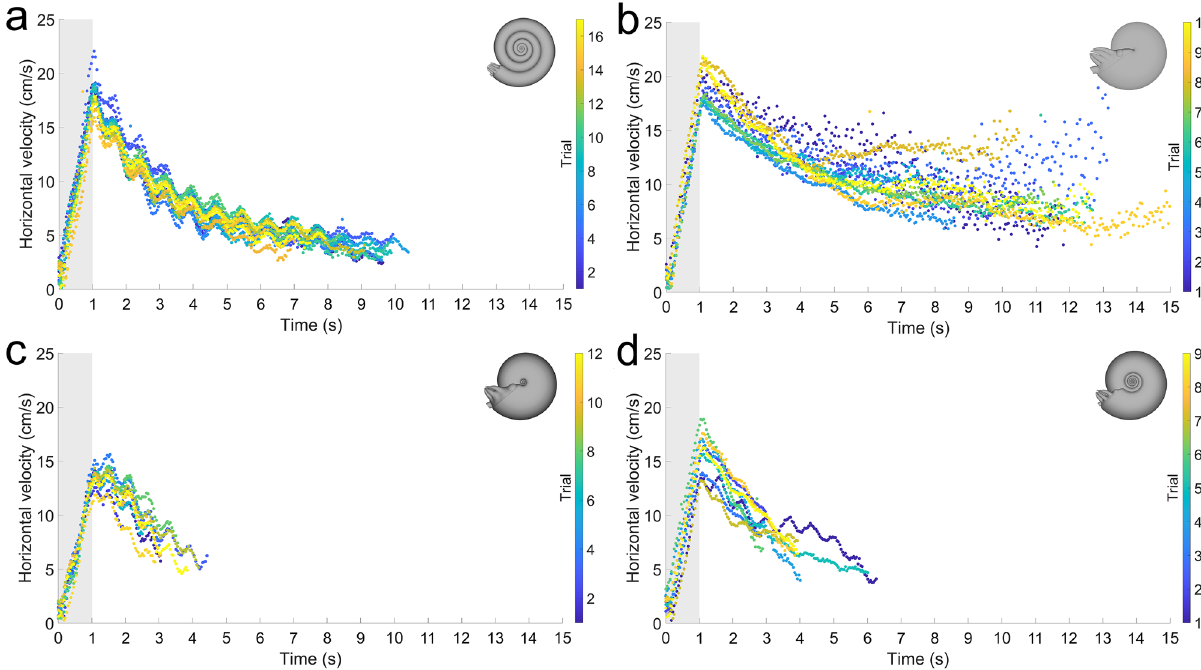
Figure 5. Velocities (horizontal components) for each model after initiating a single, one-second jet pulse. ( a ) Serpenticone, ( b ) oxycone, ( c ) sphaerocone, and ( d ) morphospace center. Shaded regions (first second) denote the time the motor was active. Colors indicate the trial performed for each robot.